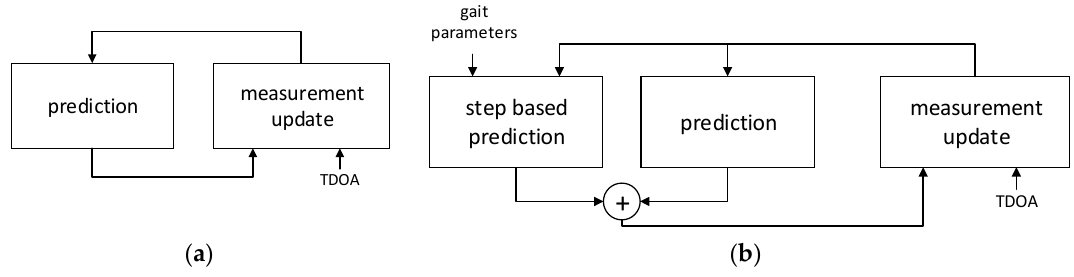
Figure 11. Localization algorithms workflow scheme: ( a ) basic Extended Kalman Filter utilizing TDOA measurement results; and ( b ) localization algorithm used in the system.